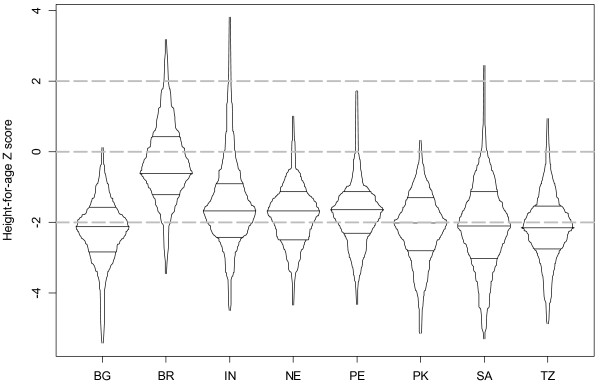
Box-percentile plots of height-for-age (HAZ) by country; 2009–10.